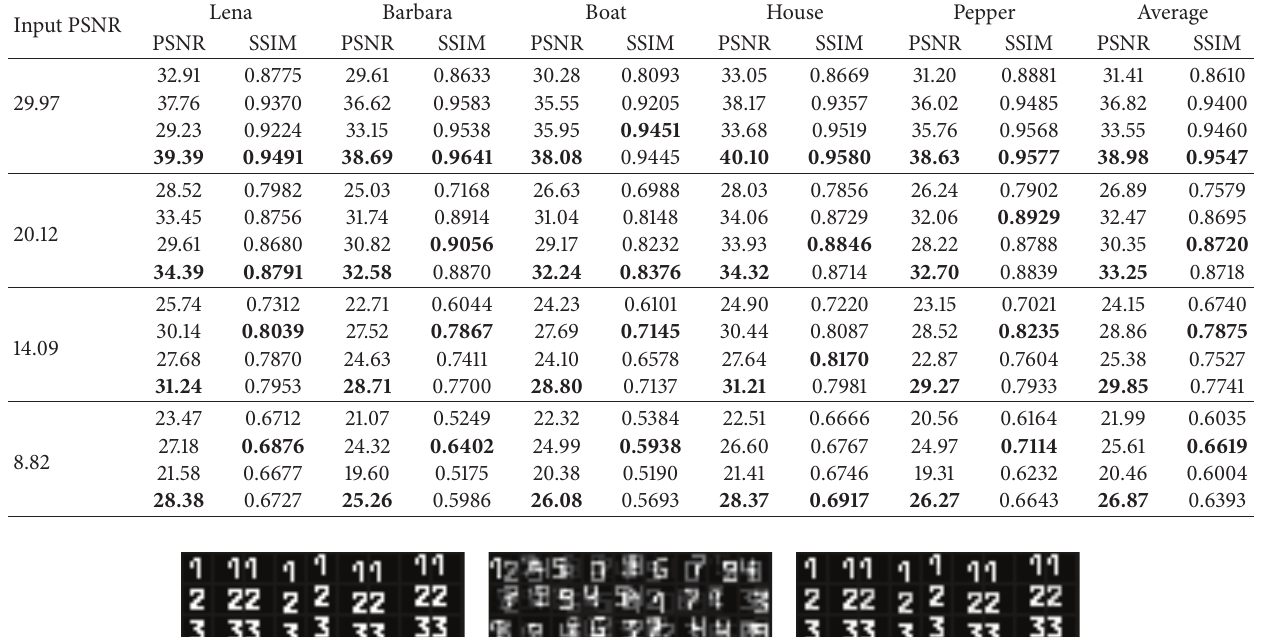
Table 1: PSNR (dB) and SSIM results for different algorithms. In each cell, four groups of denoising results are shown. Top row, Wavelets; second row, NL-means; third row, NMF ℓ 0 -H; bottom row, PCDDL.